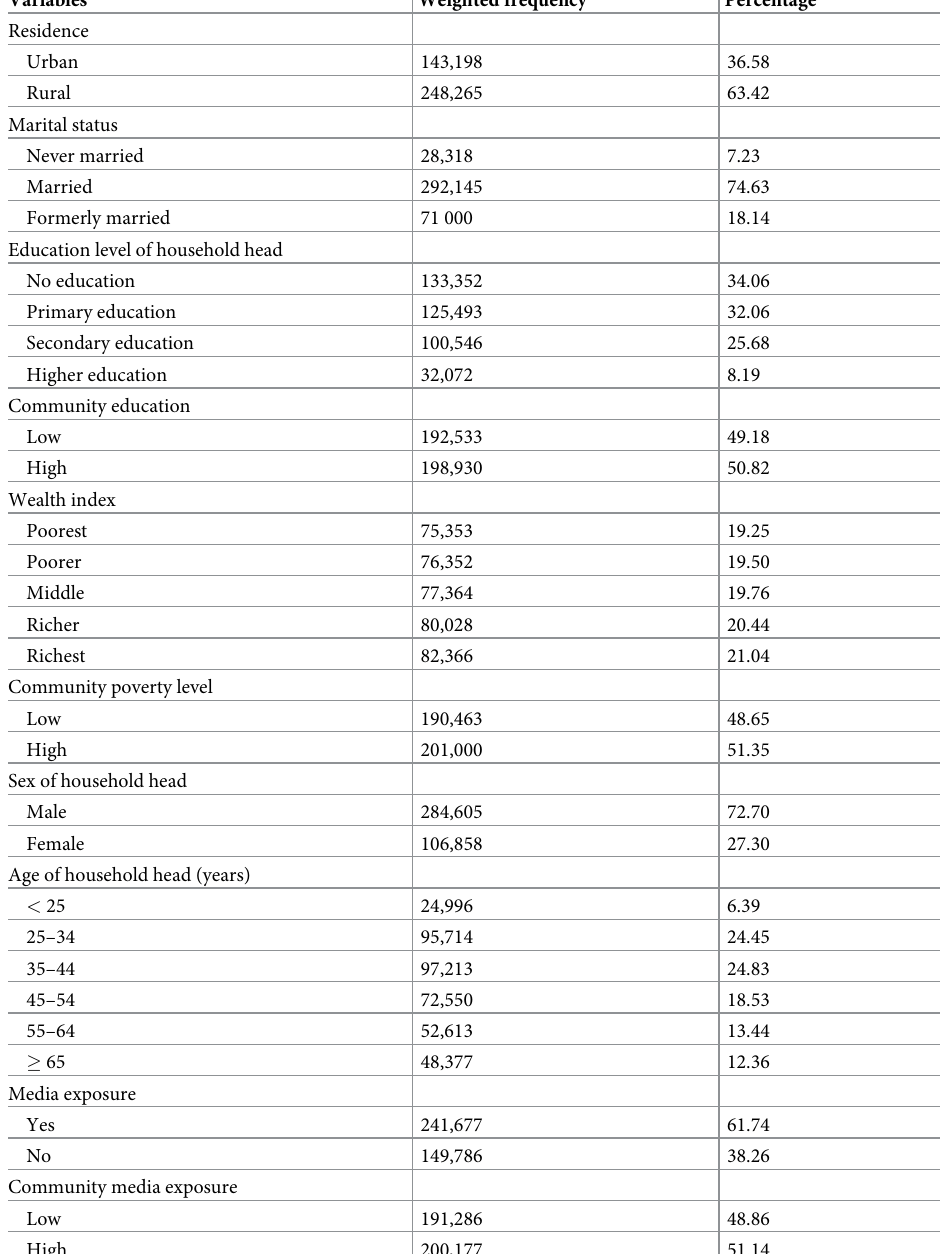
Table 2. Socio demographic characteristics of